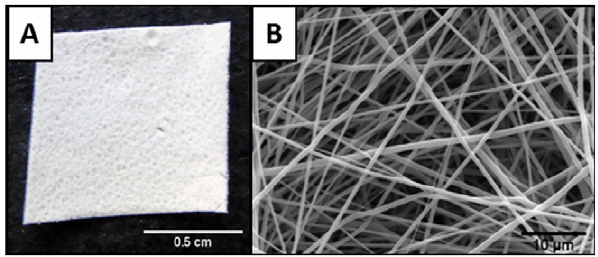
Figure 1. Structure of the electrospun PHB/PHB-HV fiber mesh. (A) Digital photograph of the electrospun PHB/PHB-HV fiber mesh surface; (B) SEM micrograph illustrating the disposition of the